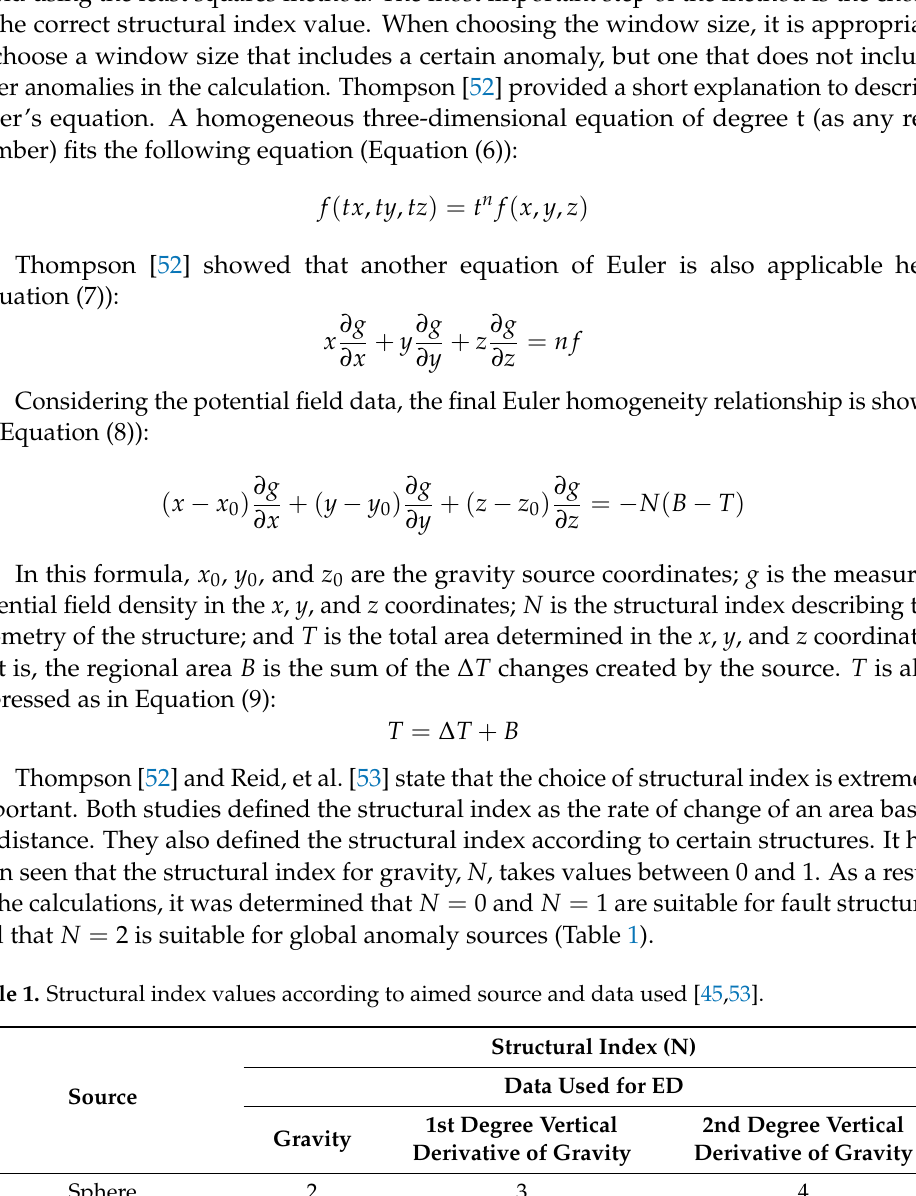
Table 1. Structural index values according to aimed source and data used [45,53]. Structural Index (N) Data Used for ED Source 1st Degree Vertical 2nd Degree Vertical Gravity Derivative of Gravity Derivative of Gravity Sphere 2 3 4 Horizontal Cylinder 1 2 3 Half-Infinite Thin Layer 0 2 or Step Half-Infinite Contact − 1 Half-Infinite Thin